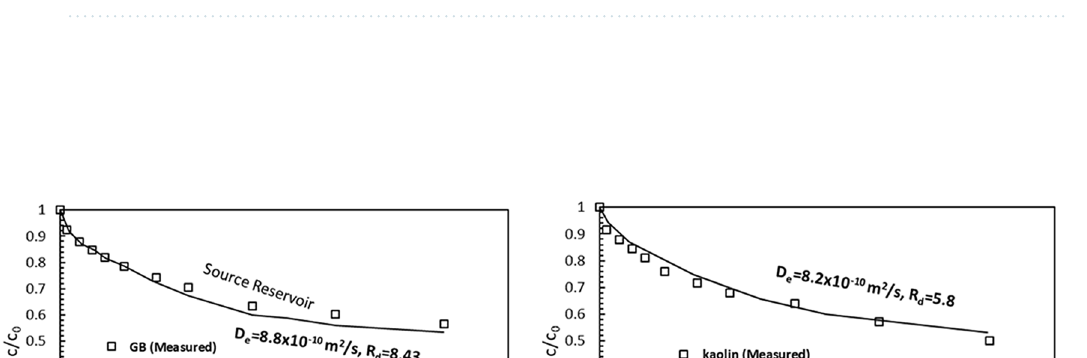
Figure 4. Comparison of the temporal variation of the normalized thickness for the GB and kaolin-GB layered system in the presence of 0.5 M concentration of ( a ) NaCl; ( b ) KCl, ( c ) CaCl 2 under applied stress of 50 kPa; comparison of the normalized thickness of the GB, kaolin, the kaolin-GB layered system in the presence of 0.5 M KCl under 50 kPa stress.